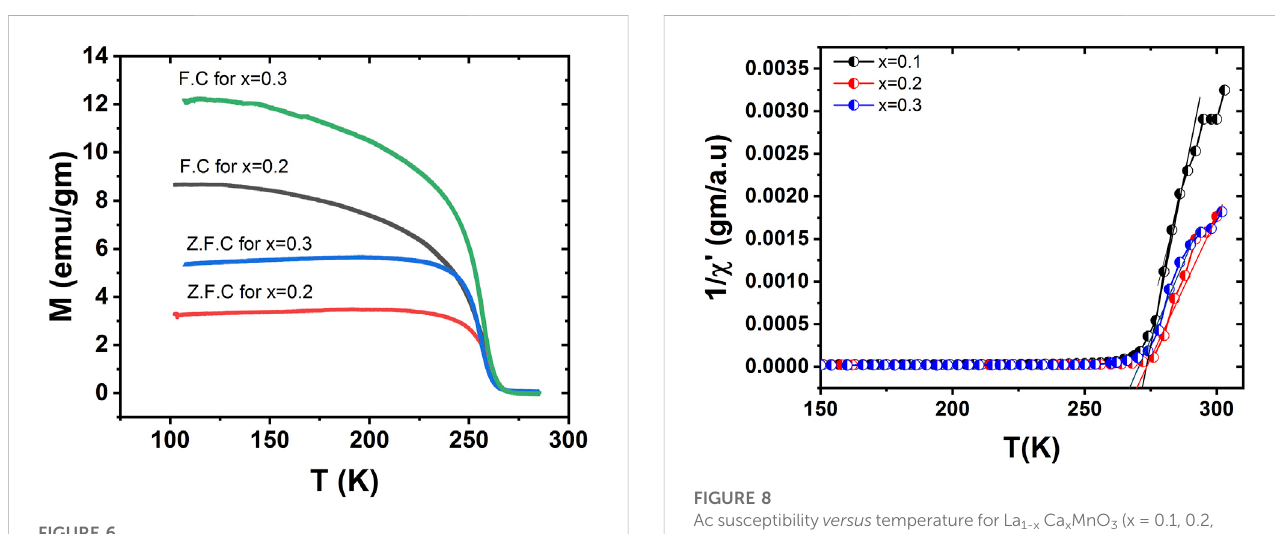
FIGURE 6 FC and ZFC DC magnetizationas afunction oftemperaturefor La 1- x Ca x MnO 3 , where x = 0.2 and 0.3.